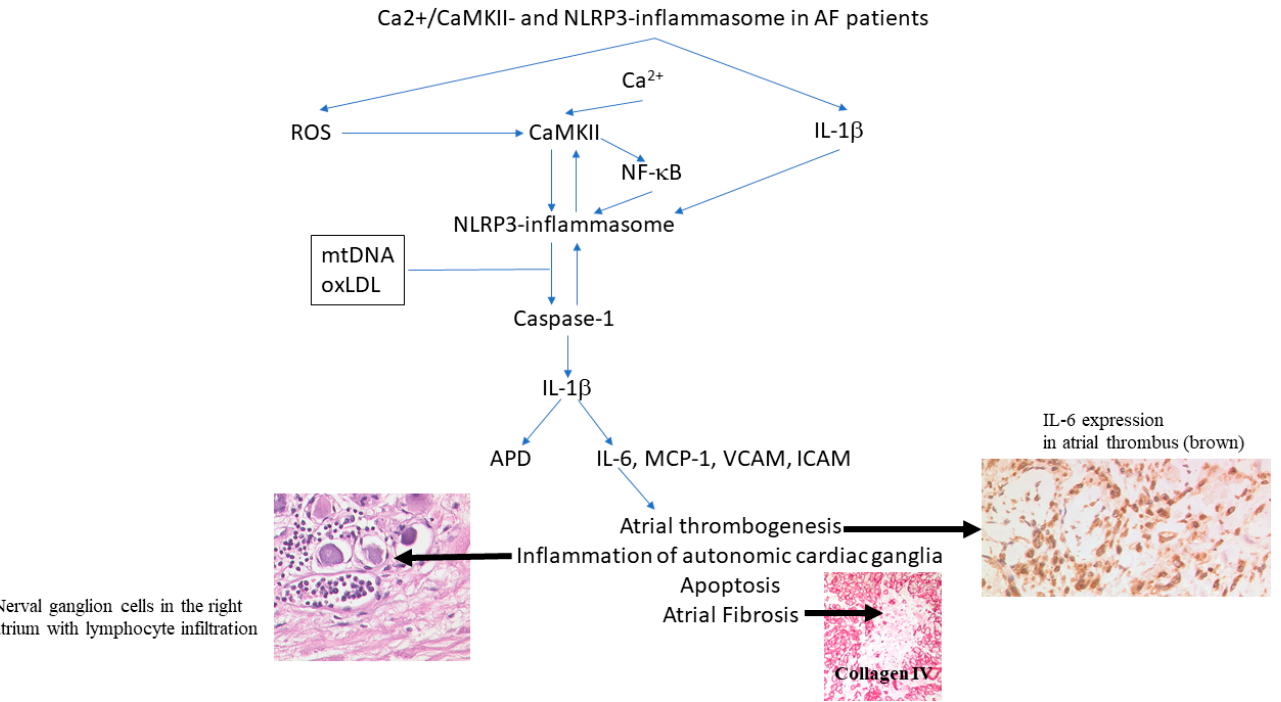
Figure 2. Interaction of atrial fibrillation (AF), CaMKII (Ca 2+ /calmodulin ‐ dependent protein kinase ‐ II), and NLRP3 (NACHT, LRR, and PYD domains ‐ containing protein 3) ‐ inflammasome.